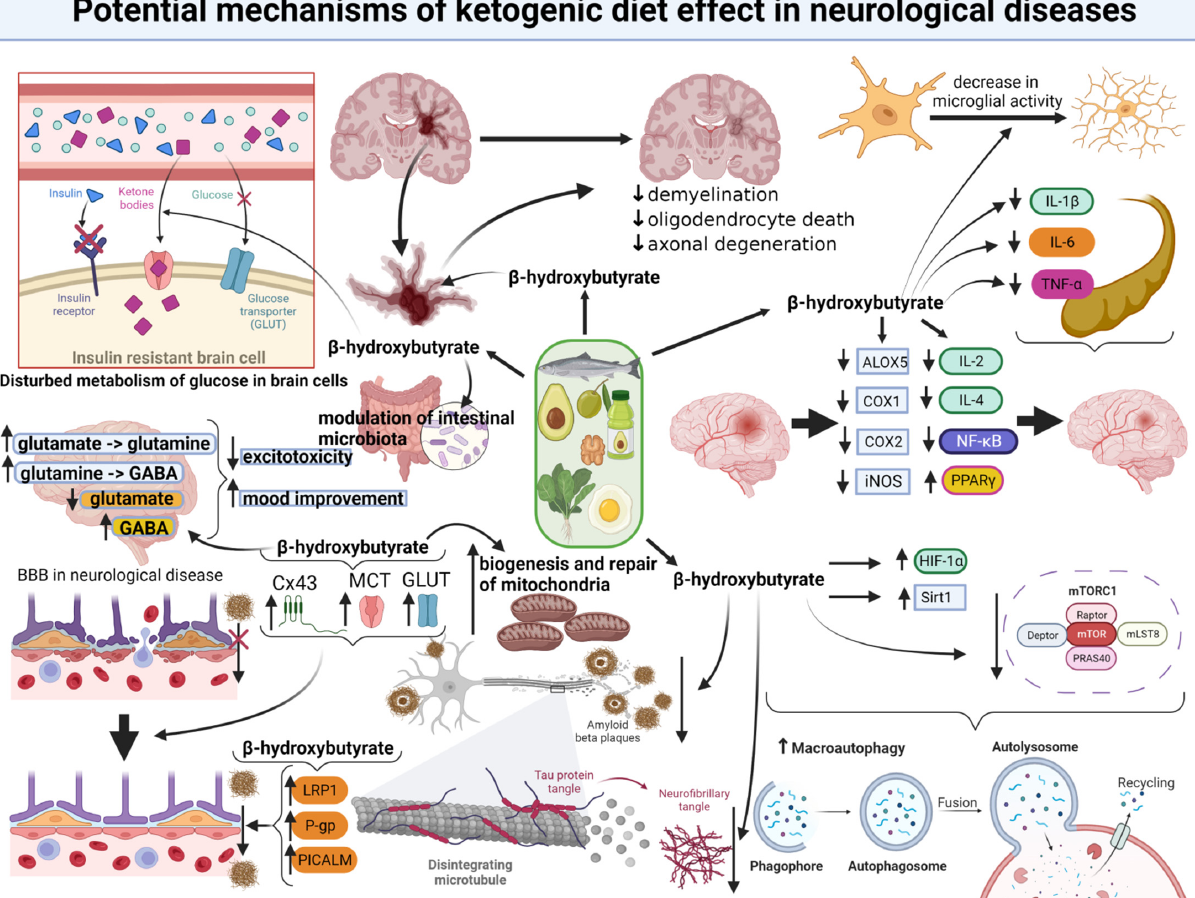
Figure 2. Potential mechanisms of the ketogenic diet effect in neurological diseases. GABA: Gamma-Aminobutyric Acid; BBB: blood–brain barrier; Cx43: connexin-43; MCT: monocarboxylate transporters; GLUT: glucose transporters; LRP1: LDL receptor-related protein 1; P-gp: glycoprotein P; PICALM: phosphatidylinositol binding clathrin assembly protein; IL-1 β : interleukin-1 β ; IL-6: interleukin-6; TNF- α : tumor necrosis factor α ; ALOX5: arachidonate 5-lipoxygenase gene; COX1: